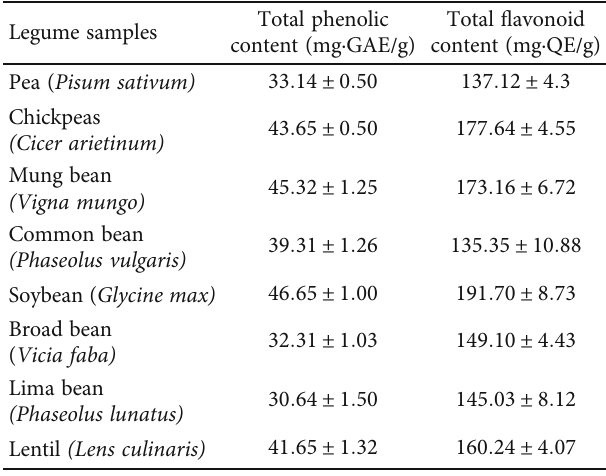
Figure 3: The α -amylase inhibitory activity against the concentrations of legume grains and standard acarbose. Table 3: Total phenolic and fl avonoid content in eight di ff erent legume